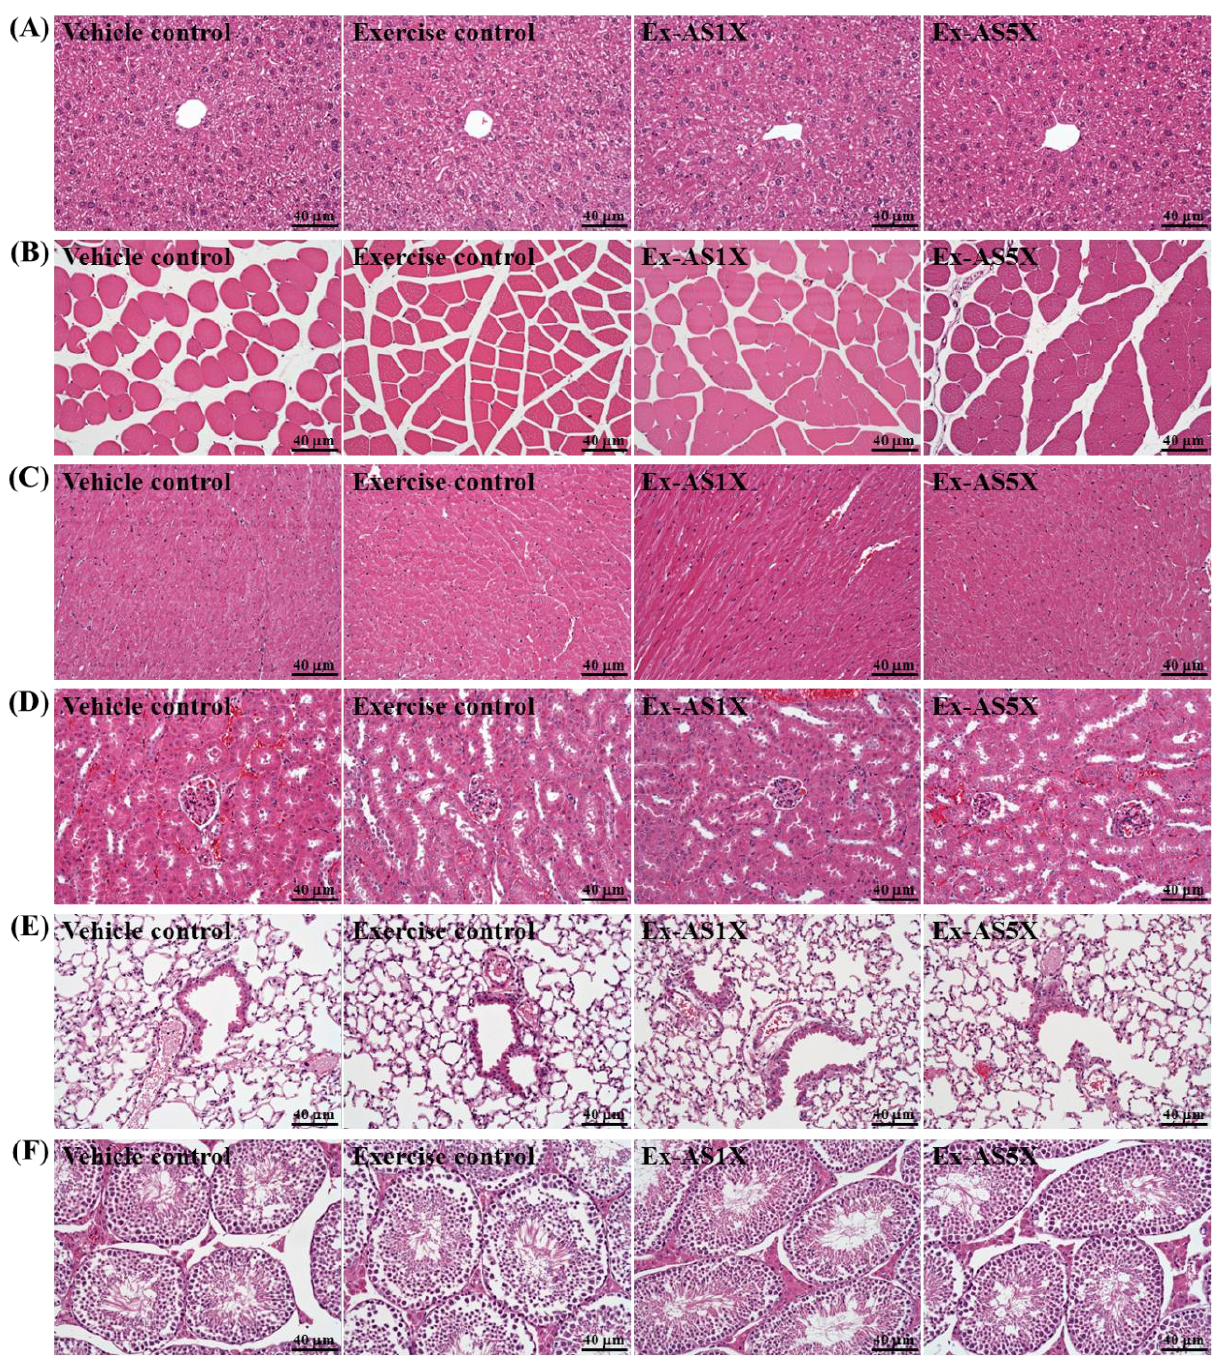
Figure 5. Effect of AS supplementation on the morphology of liver ( A ), skeletal muscle ( B ), heart ( C ), kidney ( D ), lungs ( E ), and testes ( F ) tissues. Specimens were photographed